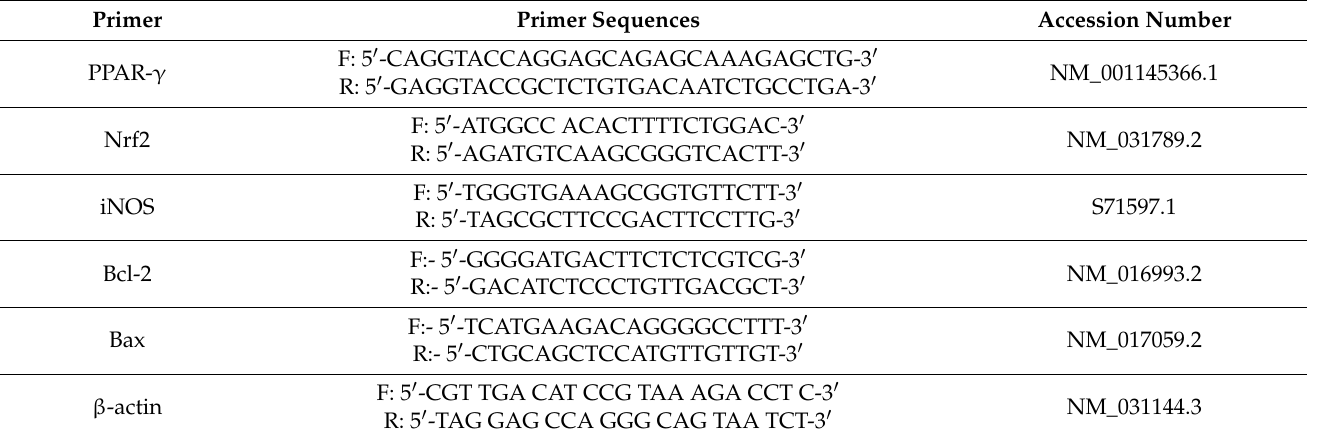
Table 2. Primer sequences used in the current